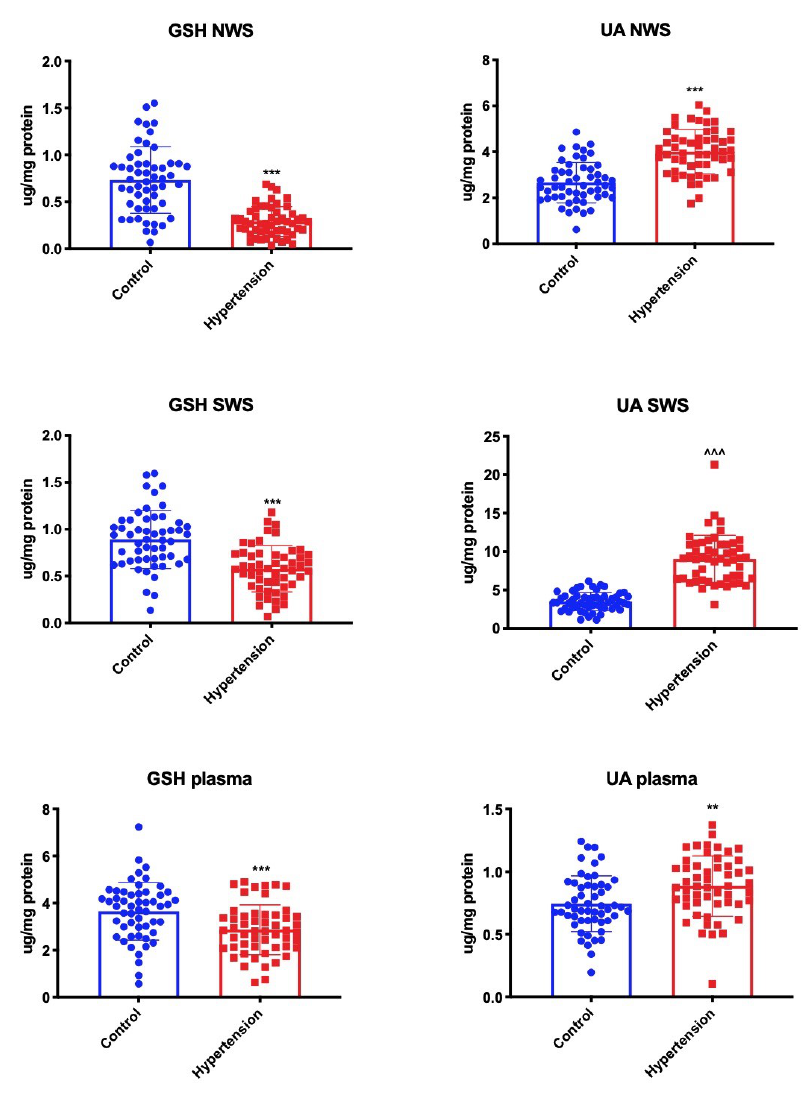
Figure 2. Non-enzymatic antioxidants in children with hypertension and healthy controls. GSH— reduced glutathione; NWS—non-stimulated whole saliva; SWS—stimulated whole saliva; UA—uric acid. Differences statistically significant at: ** p < 0.01, *** p < 0.001 (Student’s t-test); ^^^ p < 0.001 (Mann–Whitney U-test).